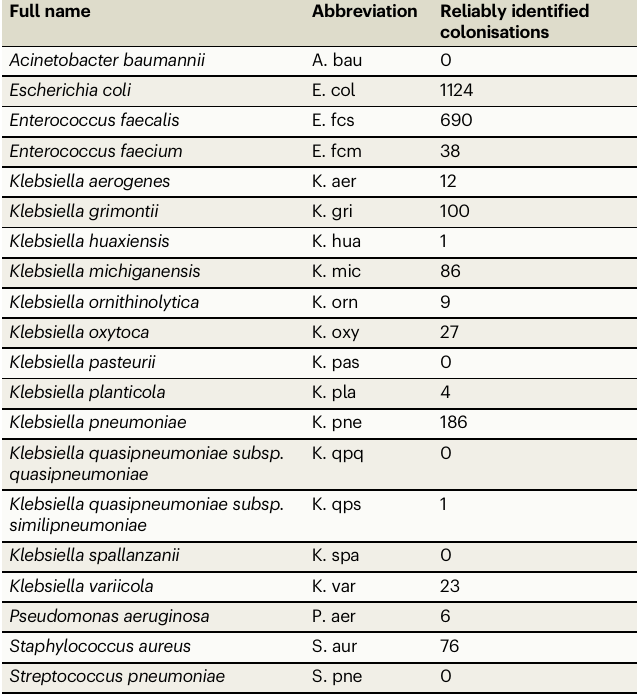
Table 2 | List of the target pathogen species, abbreviations of their names used in the manuscript, and the numbers of times lineages of each species were identi fi ed reliably in the metagenomics data using the mGEMS